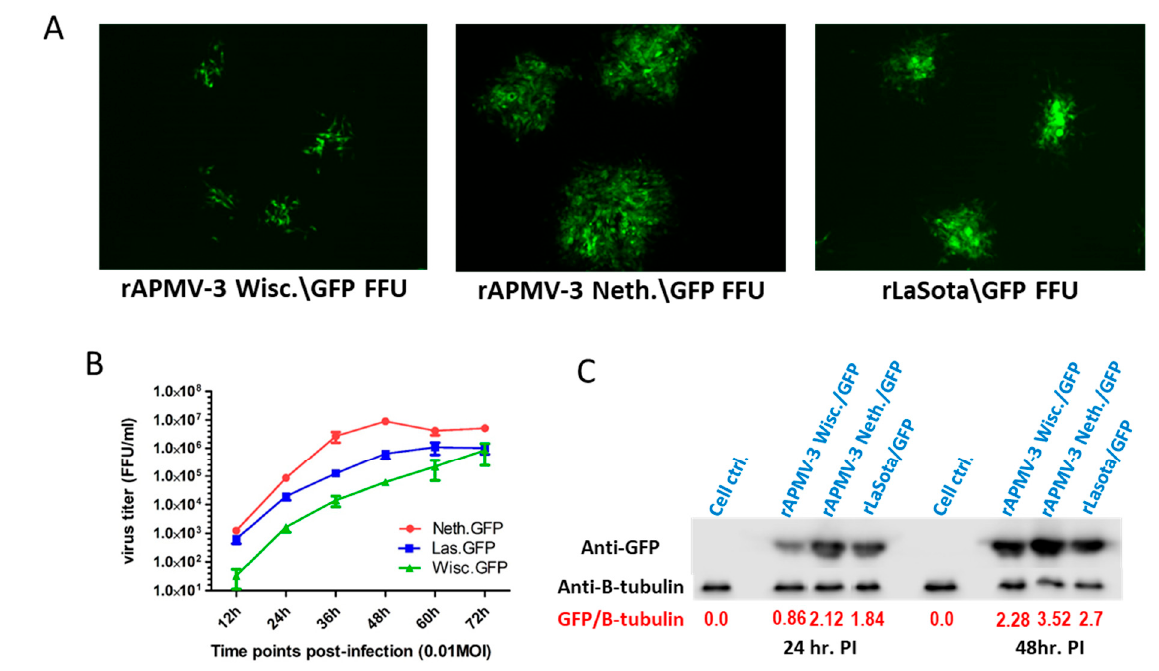
Figure 3. Characterization of rLaSota \ GFP, rAPMV-3 Wisc. \ GFP and rAPMV-3 Neth. \ GFP in DF-1 cells. ( A ) Fluorescent foci of the three recombinant vectors expressing GFP in DF-1 cells two days-post-infection. ( B ) Multicycle growth kinetics of the three viruses in DF-1 cells at 12 h intervals using 0.01 MOI of each virus. ( C ) Western blot for GFP expressed by the three viral vectors using 0.5 MOI of each virus in DF-1 cells. Cell lysate was collected 24 and 48 h post-infection and analyzed by Western blot using rabbit GFP antibodies and mouse B-tubulin antibodies.